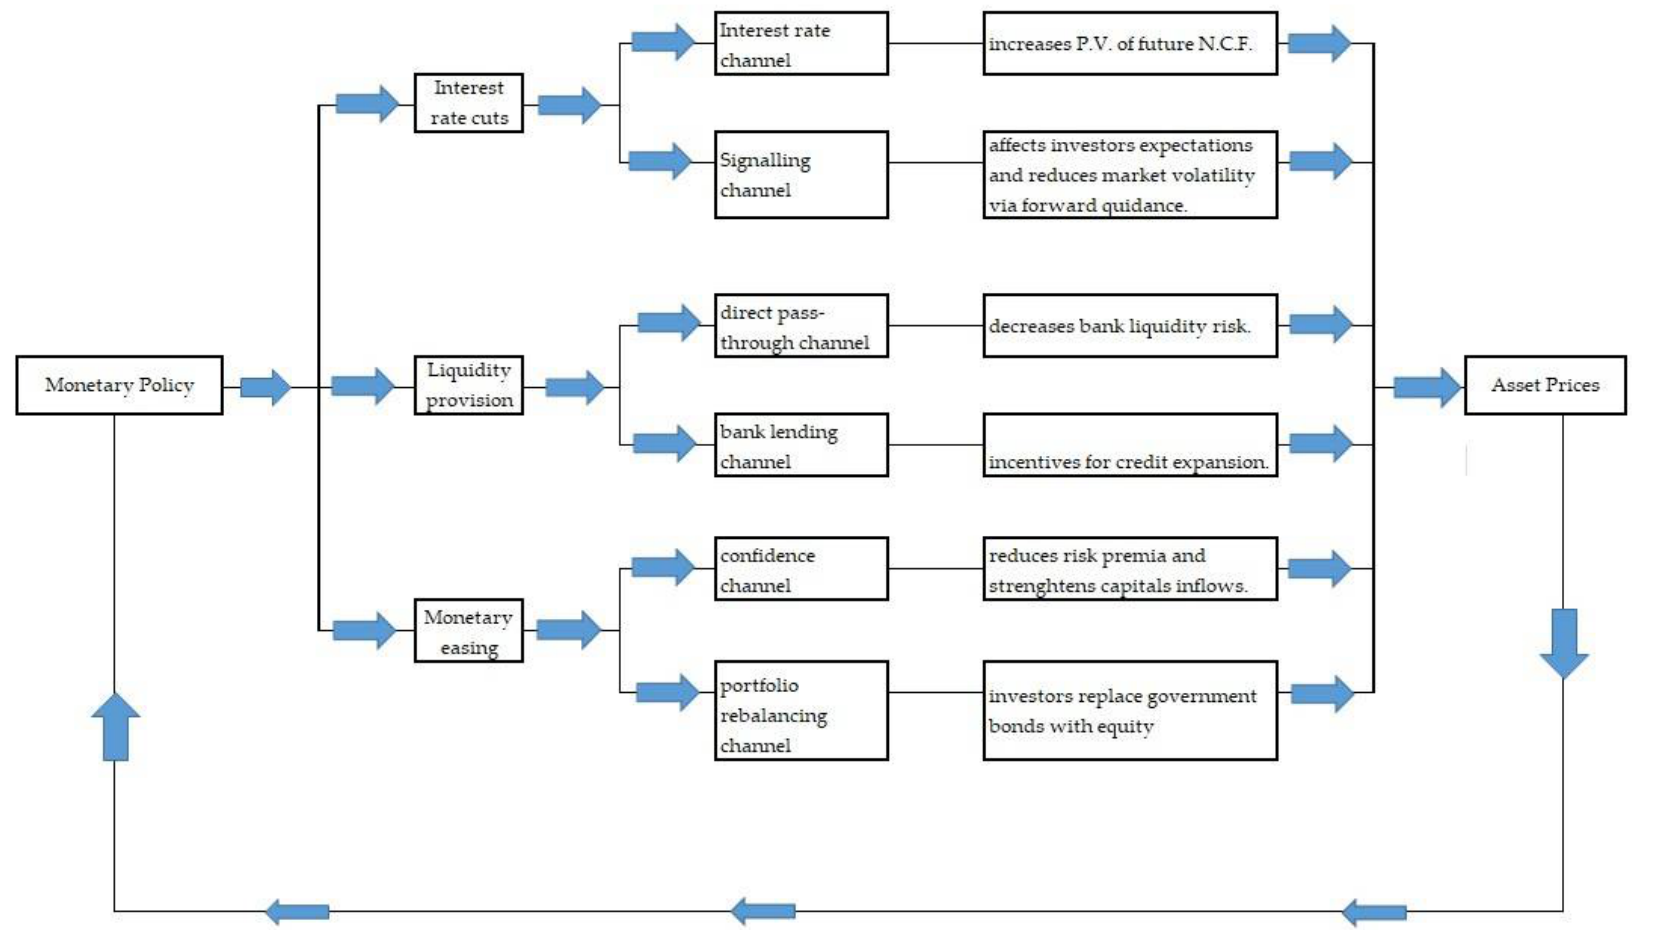
Figure 3. Cyclical effect framework (CEF) for figuring out the effect of ECB’s monetary policy interventions on asset prices, and vice versa.